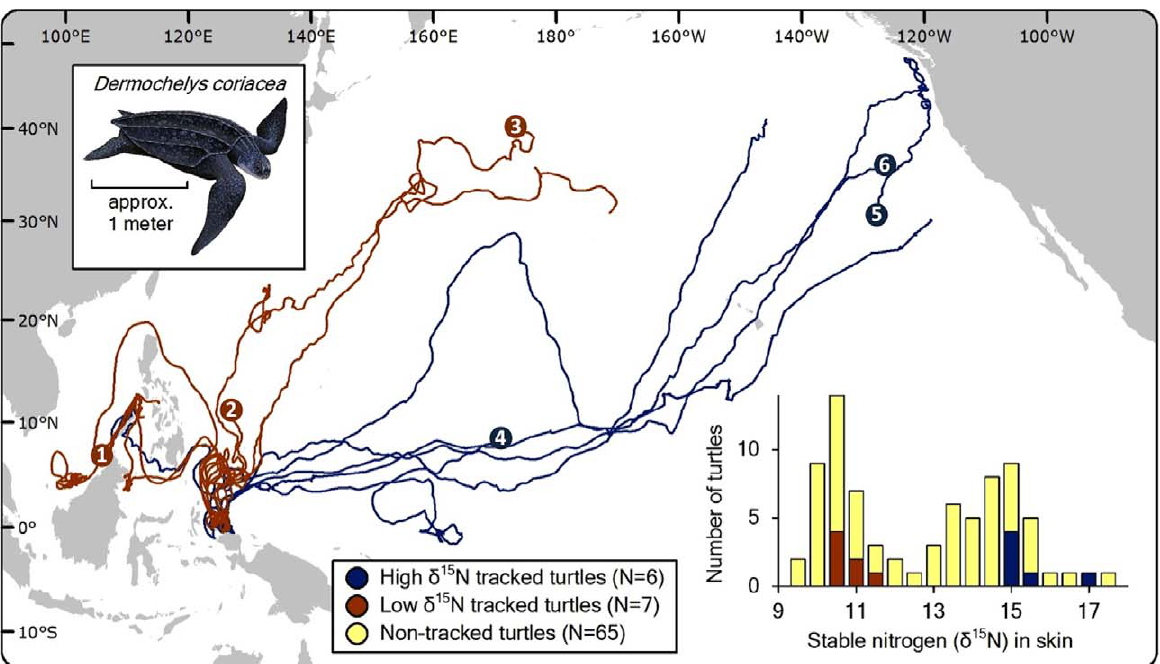
Figure 1. Map of satellite-tracked post-nesting movements of 13 leatherback turtles from Jamursba-Medi, Papua Barat Province Indonesia, overlaid with stable nitrogen isotopic values for skin tissue of nesting females from the same population. Satellite-tracked turtles were studied in 2007 and 2010; non-tracked turtles ( n =65) were skin sampled in 2005–2007 and 2010. Blue and red track lines depict turtles within the ‘high d 15 N’ and ‘low d 15 N’ groups, respectively. Tracks with numbered termini depict movements of leatherbacks that were analysed for